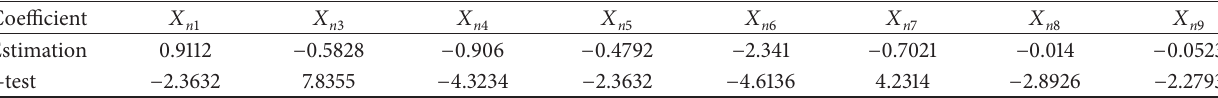
Table 3: Coefficient estimation for explanatory variable.